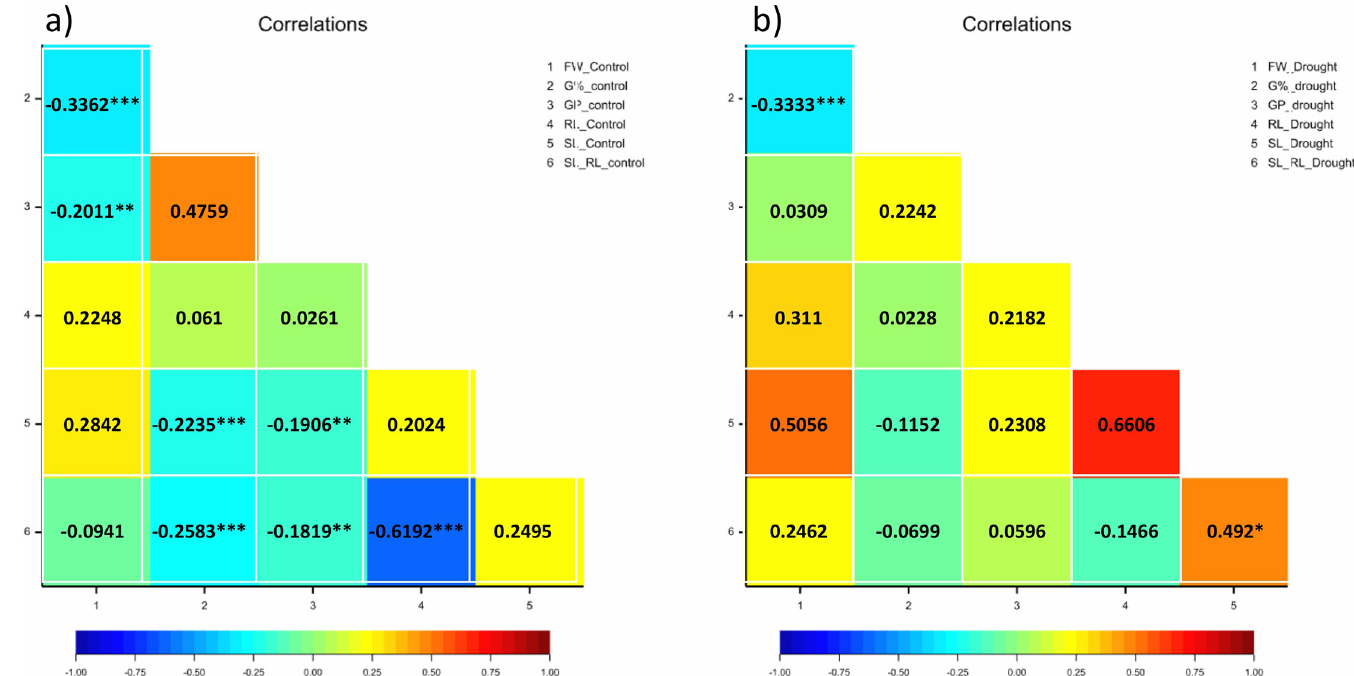
Fig 3. Correlations of the studied traits in barley genotypes (a) under control and (b) drought stress (20% PEG). The degree of significance indicated as � P, 0.05; �� P, 0.01; ��� P, 0.001.